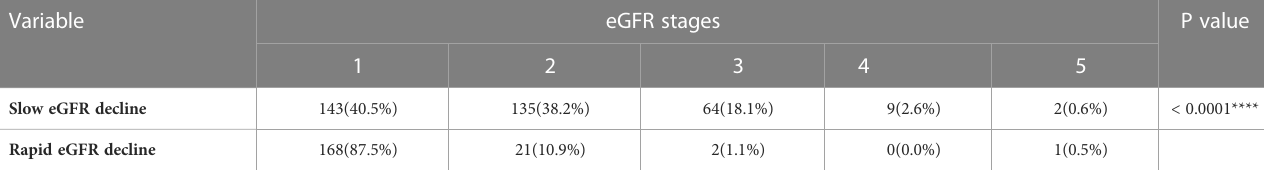
TABLE 5 Proportion of different eGFR stages in rapid eGFR decline and slow eGFR decline groups. Variable